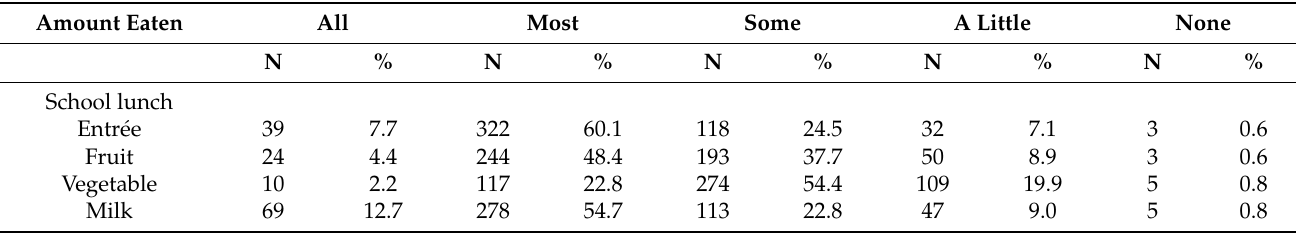
Table 4. Perception of amount of school lunch components that students eat (i.e., not wasted), at 542 US public elementary schools, 2019–20 school year.